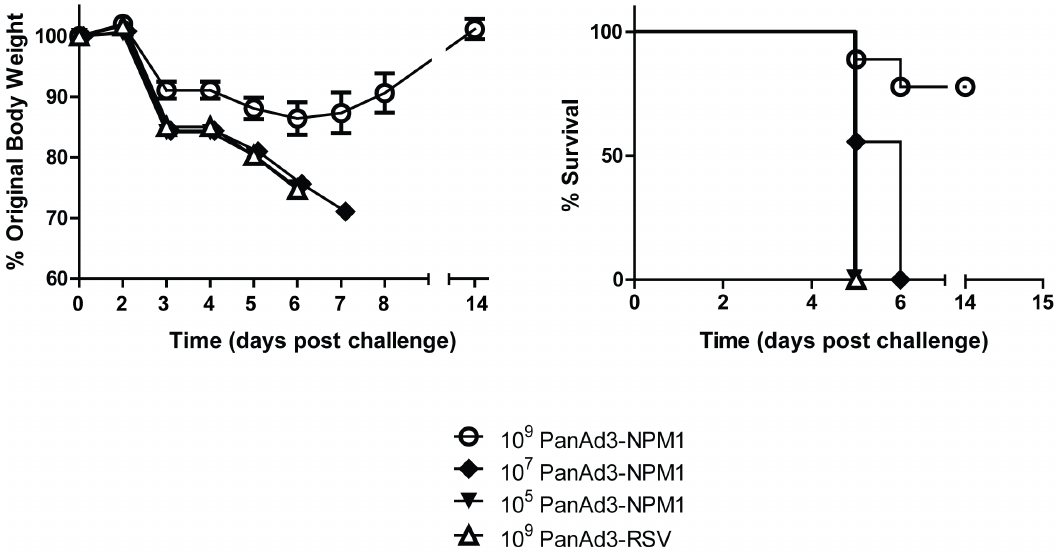
Figure 6. Protection against lethal influenza challenge by PanAd3-NPM1. Mice were immunized as in Figure 3 . Approximately 9 weeks post-immunization, mice were challenged with influenza virus A/FM at a dose of 10 4 TCID 50 (100 LD 50 ) per mouse, and monitored for body weight and mortality. Survival of the PanAd3-NPM1 group at the dose of 10 9 vp differs significantly (p , 0.05) from the PanAd3-RSV control group. Error bars indicate mean 6